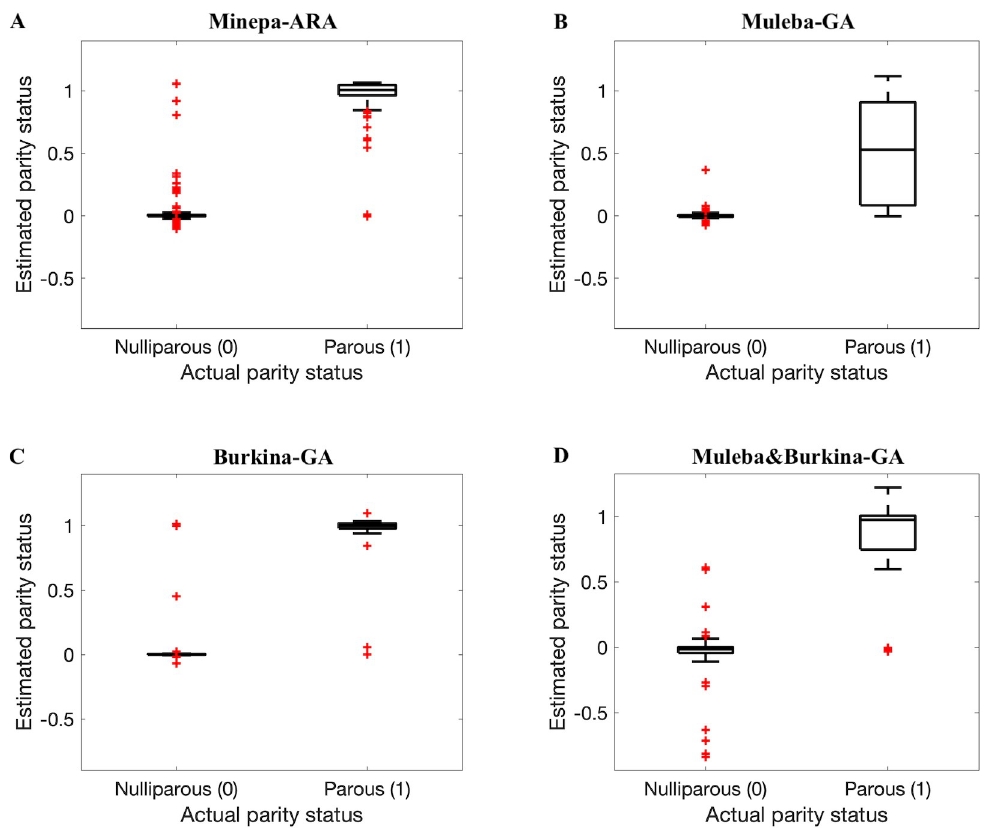
Fig 9. Box plots showing results when ANN models trained on 75% of encoded spectra in datasets were tested on the remaining encoded spectra (25%). A, B, C, and D represent results for the Encoded-Minepa-ARA, Encoded-Muleba-GA, Encoded-Burkina-GA, and Encoded-Muleba & Burkina-GA (mosquitoes in Encoded-Muleba-GA and Encoded-Burkina- GA datasets combined) datasets, respectively.